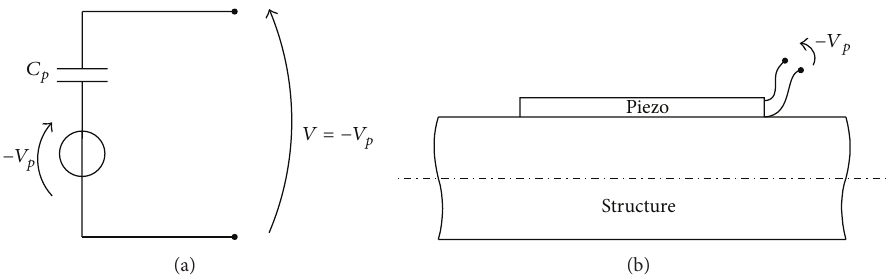
Figure 1: Electric equivalent of a piezoelectric actuator (a) bonded to an elastic structure